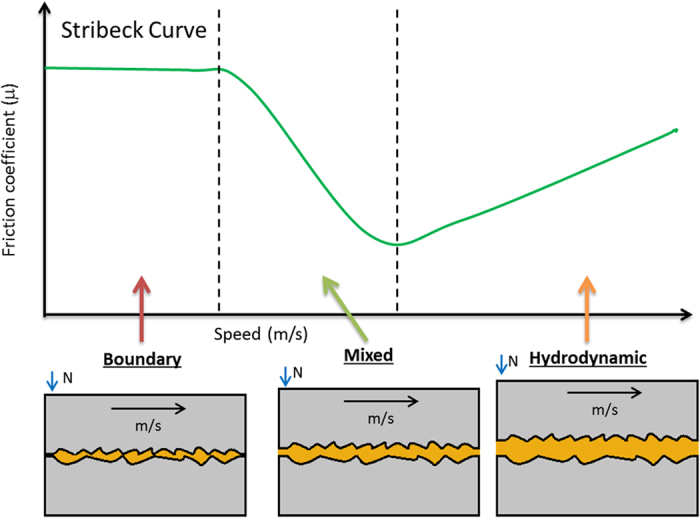
A Stribeck curve and illustrations of the 3 lubricant regimes occurring simultaneously in an engine.